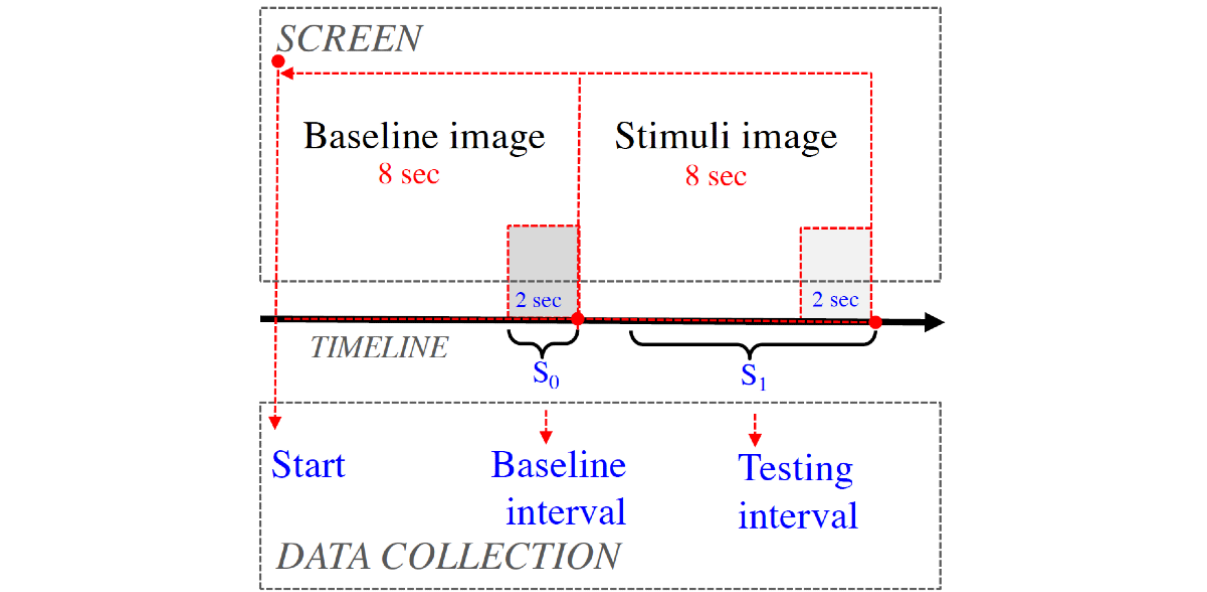
Figure 4. The procedure used to generate pupillary response data for evaluating baselines images. First, the baseline image was shown on the screen for 8 seconds, and then the in-test image was